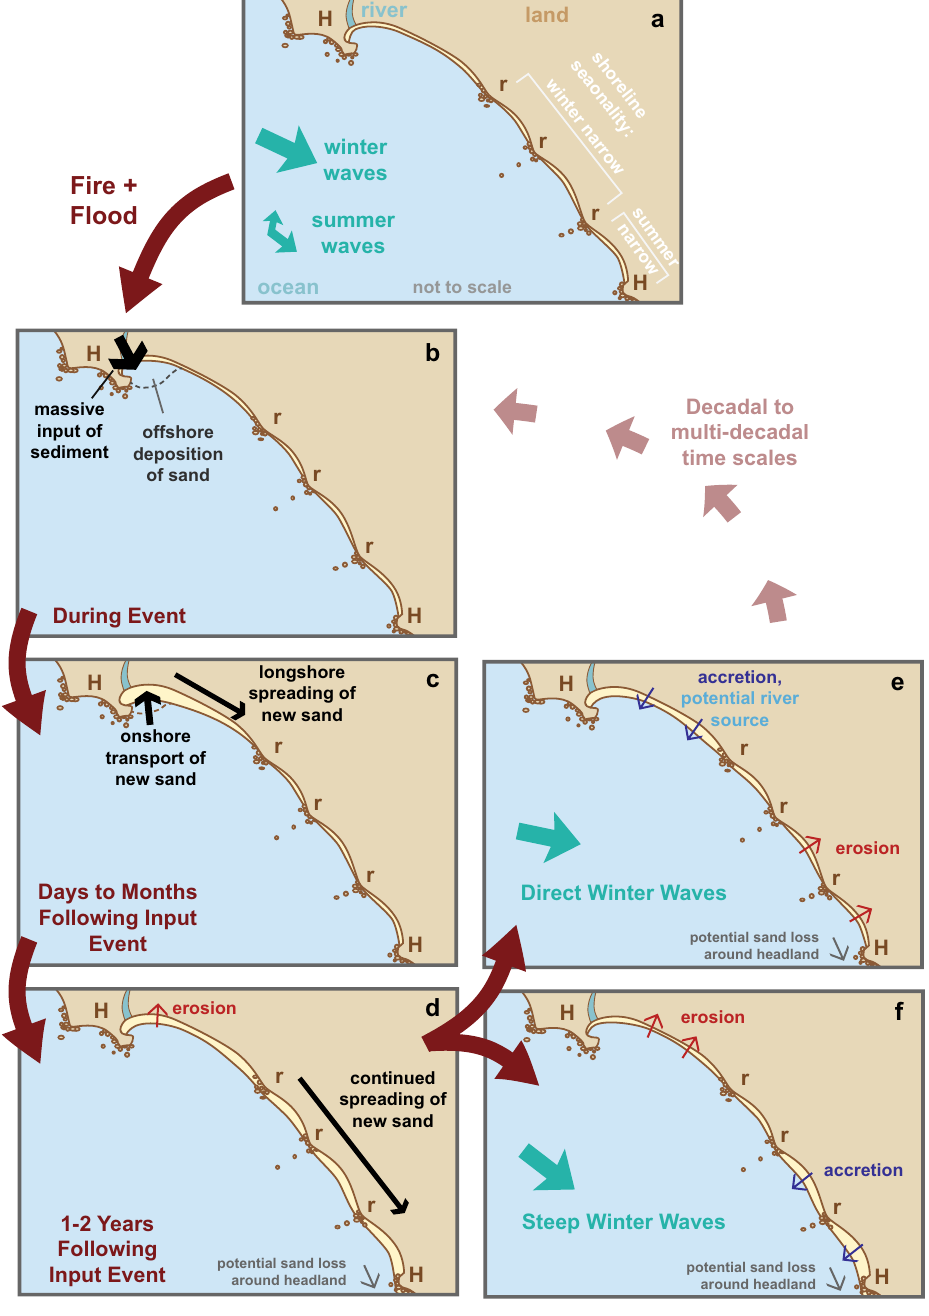
Figure 7. Conceptual model of the Big Sur River mouth littoral cell response to sediment input and wave conditions. Shoreline morphodynamics highlight changes to sandy beach widths (yellow areas) along a coast that includes two headlands (H) and several rocky areas